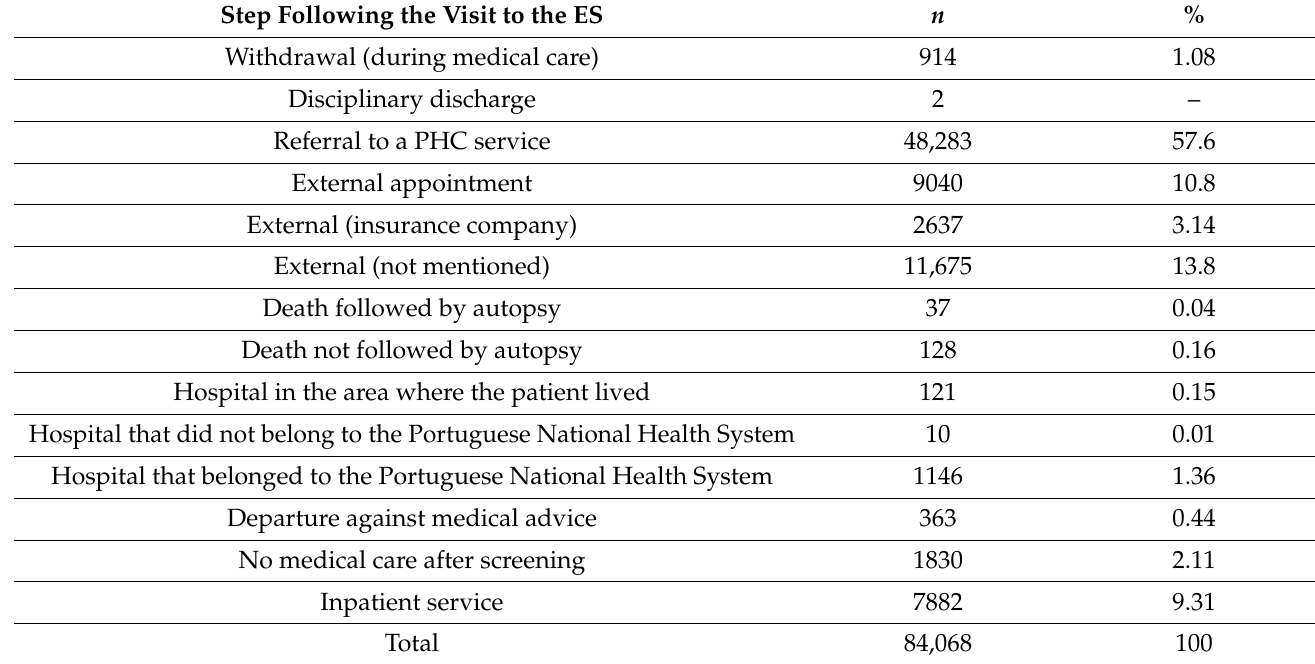
Table 1. Characterization of the visits to the ES. Vila Franca de Xira, Portugal. 1 October 2018 to 31 August